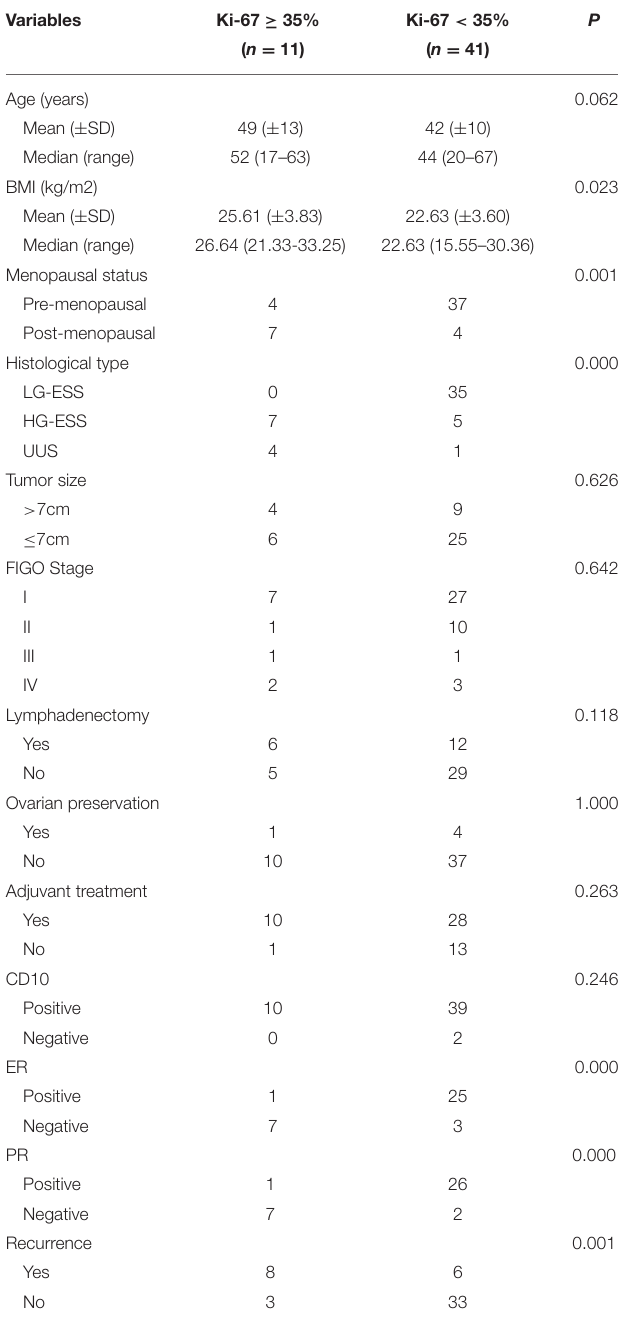
TABLE 2 | Relationship between the expression level of the Ki-67 index and clinicopathological characteristics.